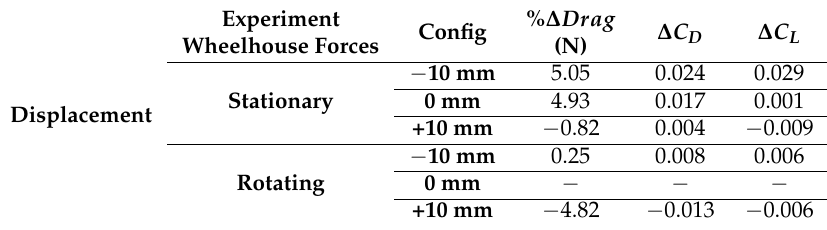
Table 5. Experimental wheelhouse forces: rotating wheel